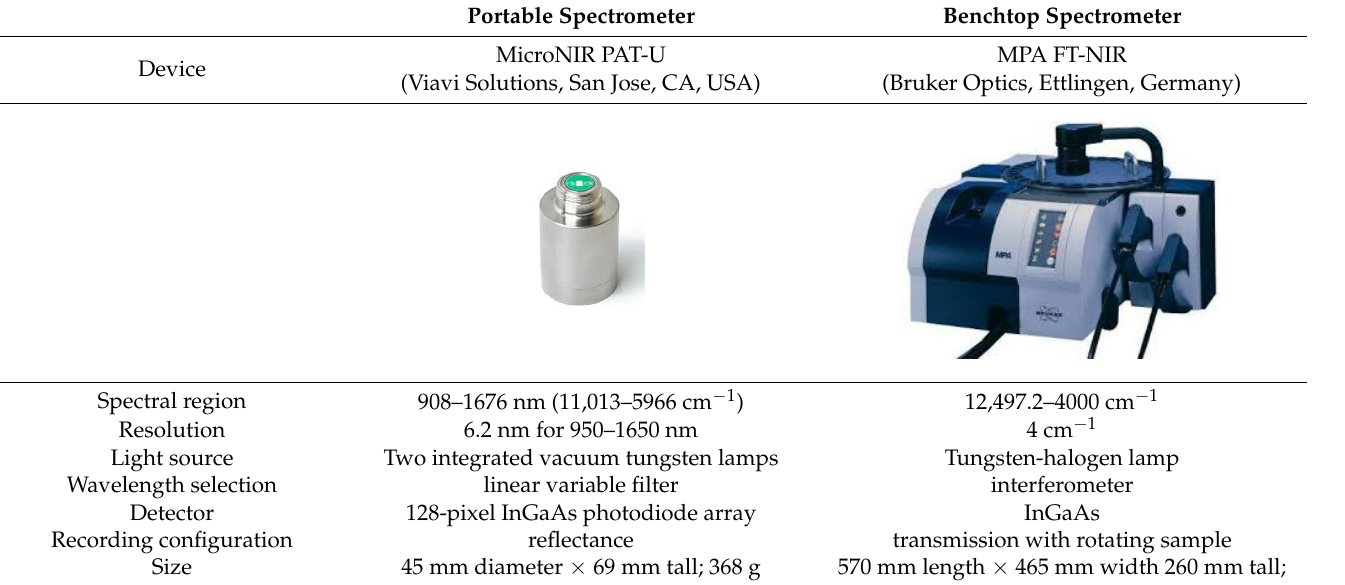
Figure 1. Accuracy (left) and linearity profiles (right) obtained for the at-line quantification of ibuprofen ( a , b ), paracetamol ( c , d ) and caffeine ( e , f ). Dotted black line: acceptability limits; Dashed blue line: upper and lower relative 95% ‐β‐ expectation tolerance limits; Continuous red line: relative bias; X: relative back ‐ cal ‐ culated concentrations of validation samples.